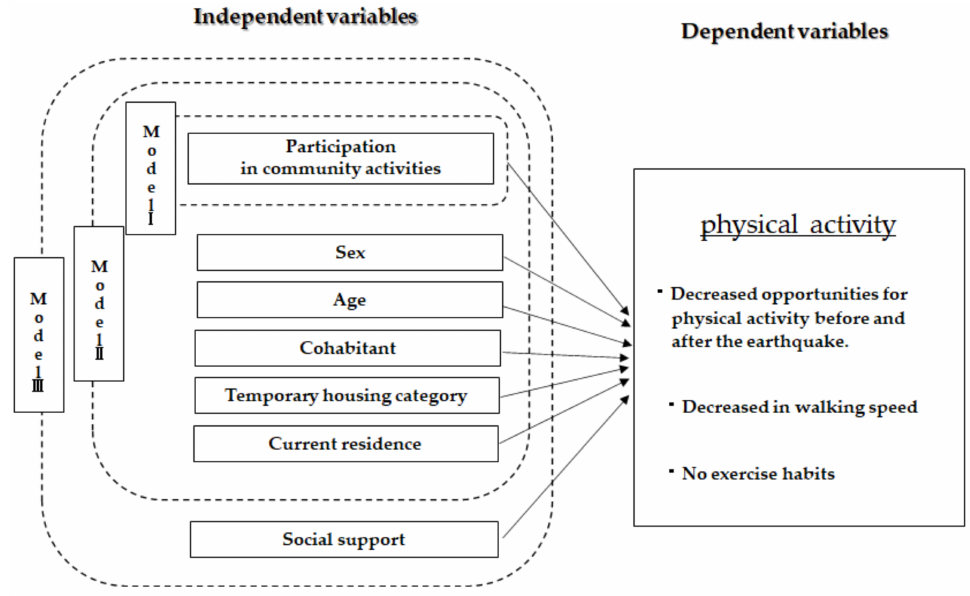
Figure 2. Model of